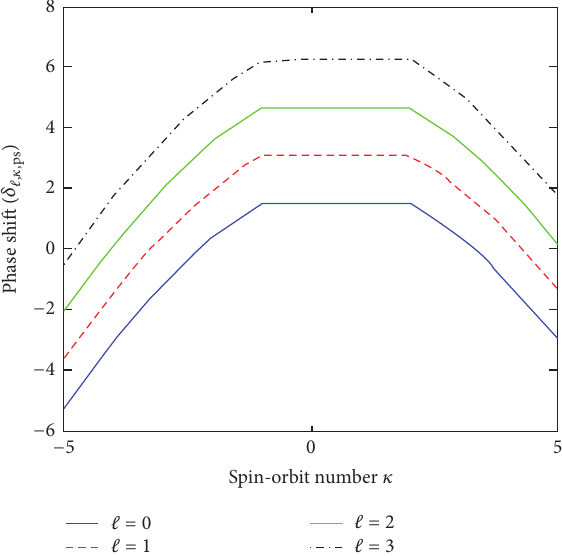
Figure 1: A plot of pseudospin scattering phase shifts for the hyperbolical potential as a function of spin-orbit number 𝜅 for 𝑙 = 0, 1, 2,3 with positive potential parameter 𝜎 = 1/12 , 𝐶 = 0 , 𝐷 = 10 , and 𝐸 = 𝑀 = 1 . The relativistic mass 𝑐 𝑜 ps and energy are equal in all the